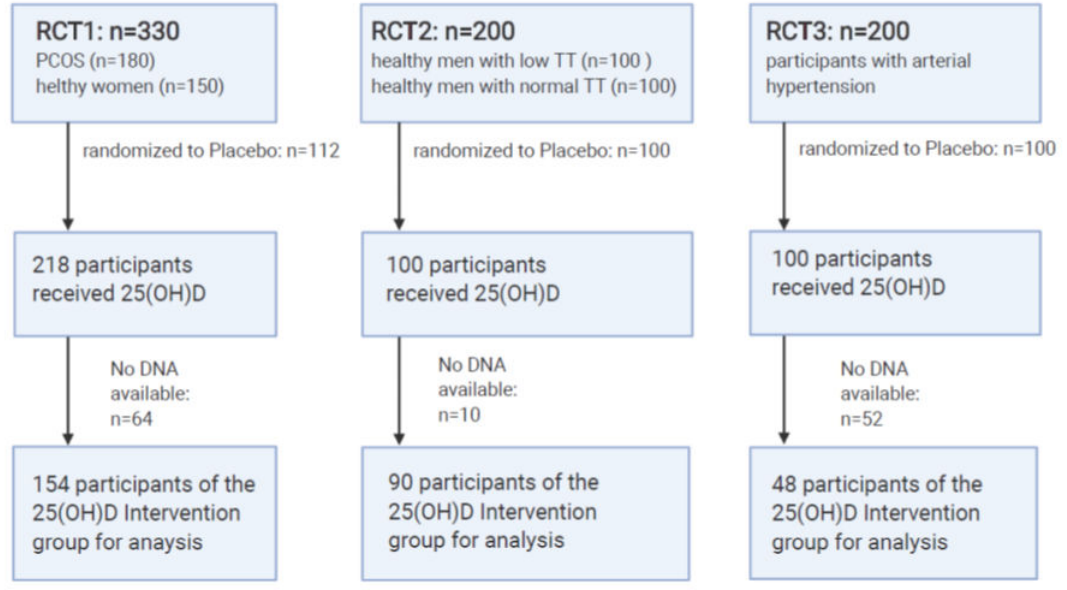
Figure 2. Study flow chart. RCT, randomized controlled trial; TT, testosterone; PCOS, polycystic ovary syndrome; n, number; DNA, deoxyribonucleic